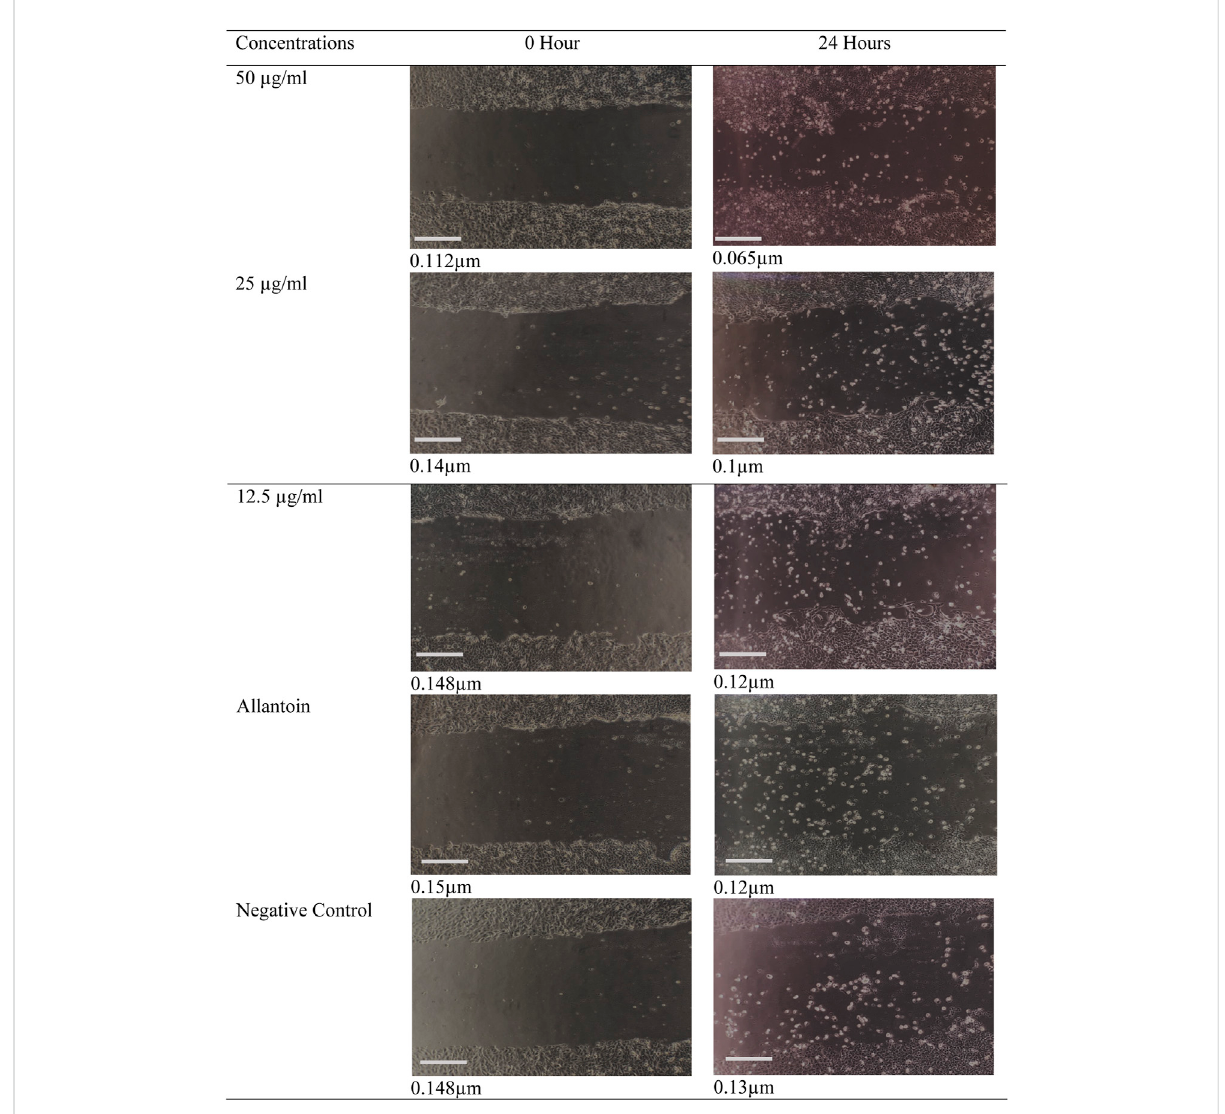
FIGURE 4 Digital image showing the effect of Oroxylum indicum leaves extracts on human keratinocyte cell migration in a scratch assay. Migrations of keratinocytes were photographed using light microscope fi tted with digital camera with ×10 magni fi cation. Bar = 1